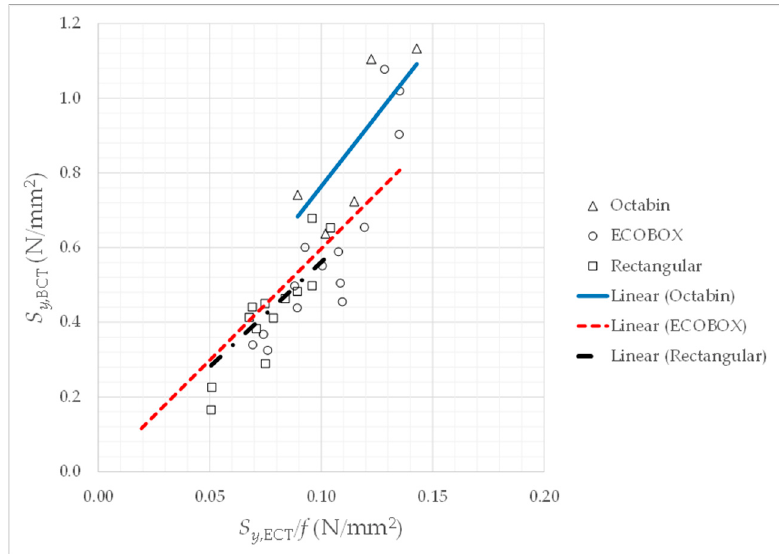
Figure 6. Settings of value m .